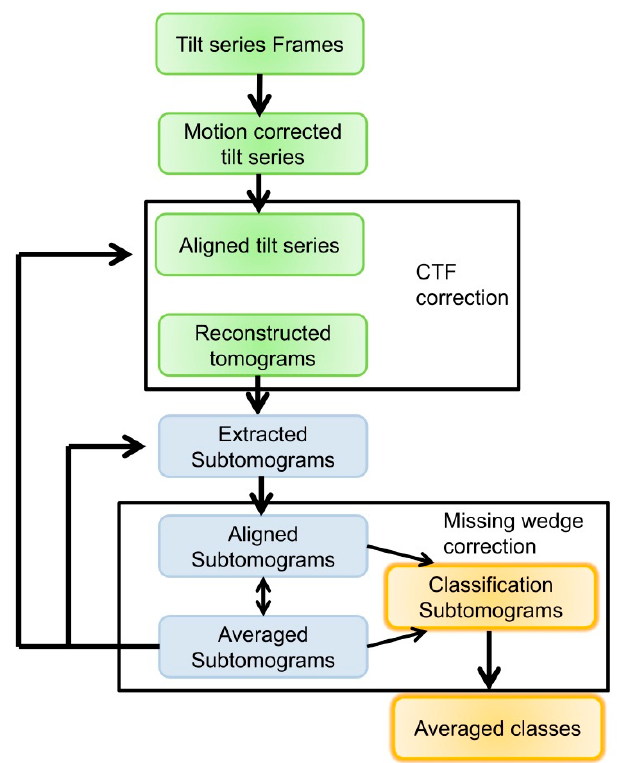
Figure 5. General workflow for the processing of tomograms and sub-tomogram averaging. First, the movies are motion-corrected, and the resulting images are aligned. The aligned tilt series is then used to calculate the tomogram. CTF correction can happen during these steps. The individual sub-tomograms are then identified and extracted. The sub-tomograms are then aligned against references and averaged. At this stage, missing wedge compensation is applied. Aligned sub-tomograms (or averaged sub-tomograms) are then classified. Processing is iterative (black arrows). Averaged sub-tomograms help to refine steps earlier in the workflow. It should be pointed out that this is a general workflow. Depending on the software, some steps are merged.